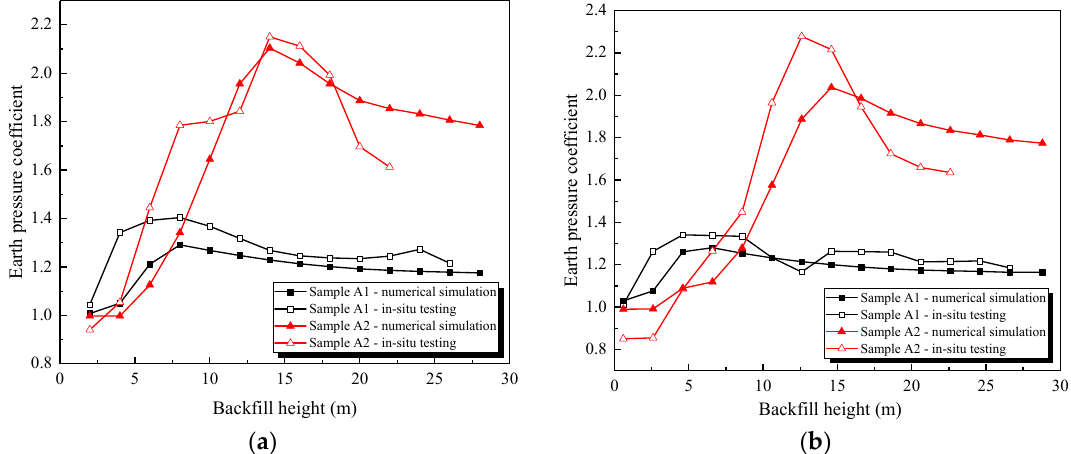
Figure 19. Earth pressure coefficient (comparison of numerical simulations and in situ testing). ( a ) Arch crown; ( b ) Arch rib.